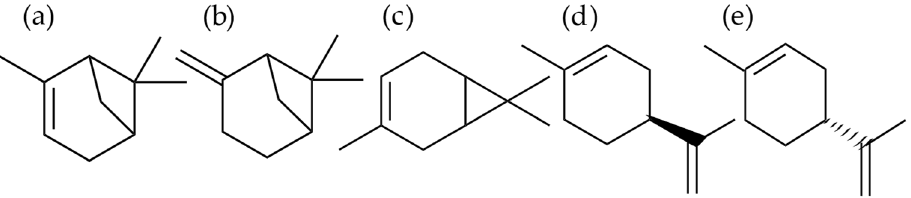
Figure 1. Molecular formula of ( a ) α -pinene, ( b ) β -pinene, ( c ) 3-carene, ( d ) S-limonene, and ( e ) R- limonene. Monoterpenes α - and β -pinene are structural isomers, and R- and S-limonene are two enantiomers found in nature, e.g., in pine (coniferous trees).